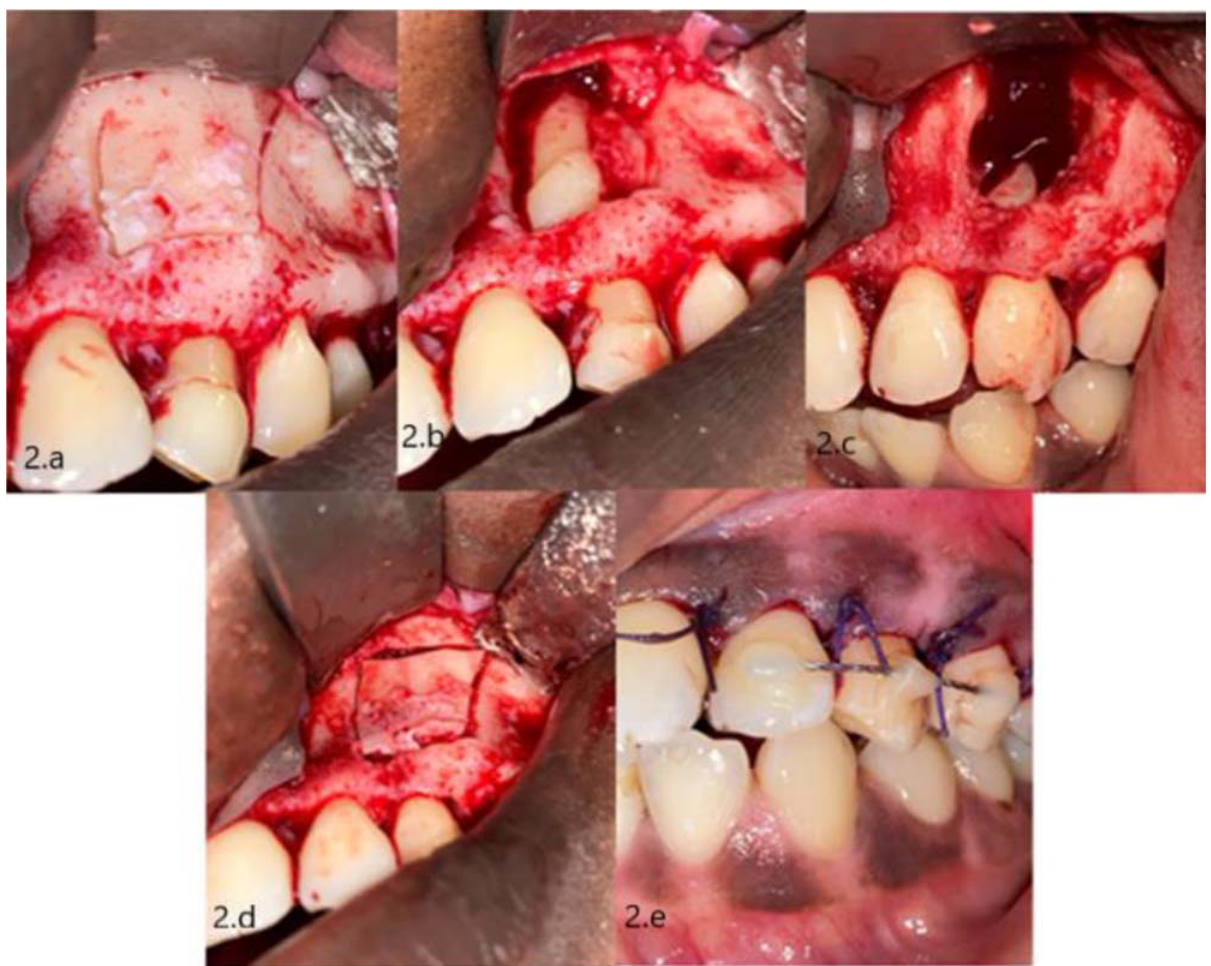
Fig. 2. (a) Trapezoidal osteotomy, (b) tooth exposure, (c) transposition, (d) bone replacement, (e) bonded